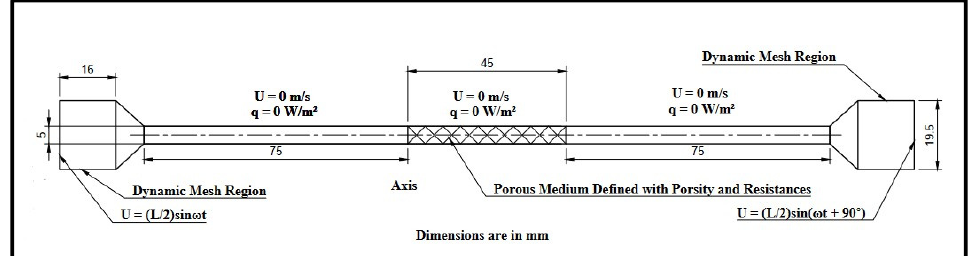
Figure 8. Boundary conditions used for numerical simulations.